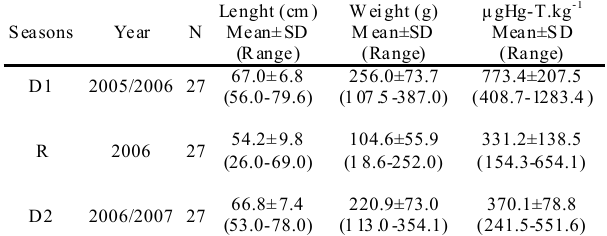
Table 2. Biological parameters and respective mean total mercury concentrations (µgHgT.kg -1 in the muscle) of Trichiurus lepturus from Goiana Estuary in the study